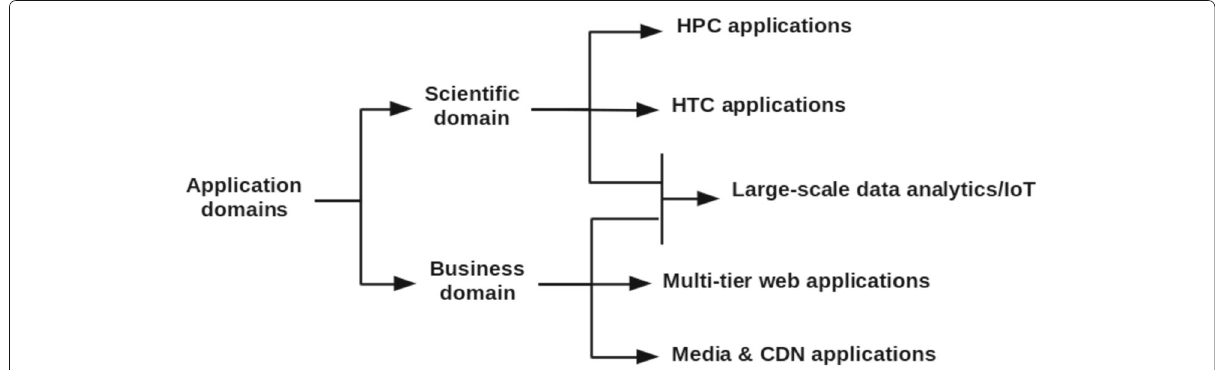
Fig. 5 Application domain